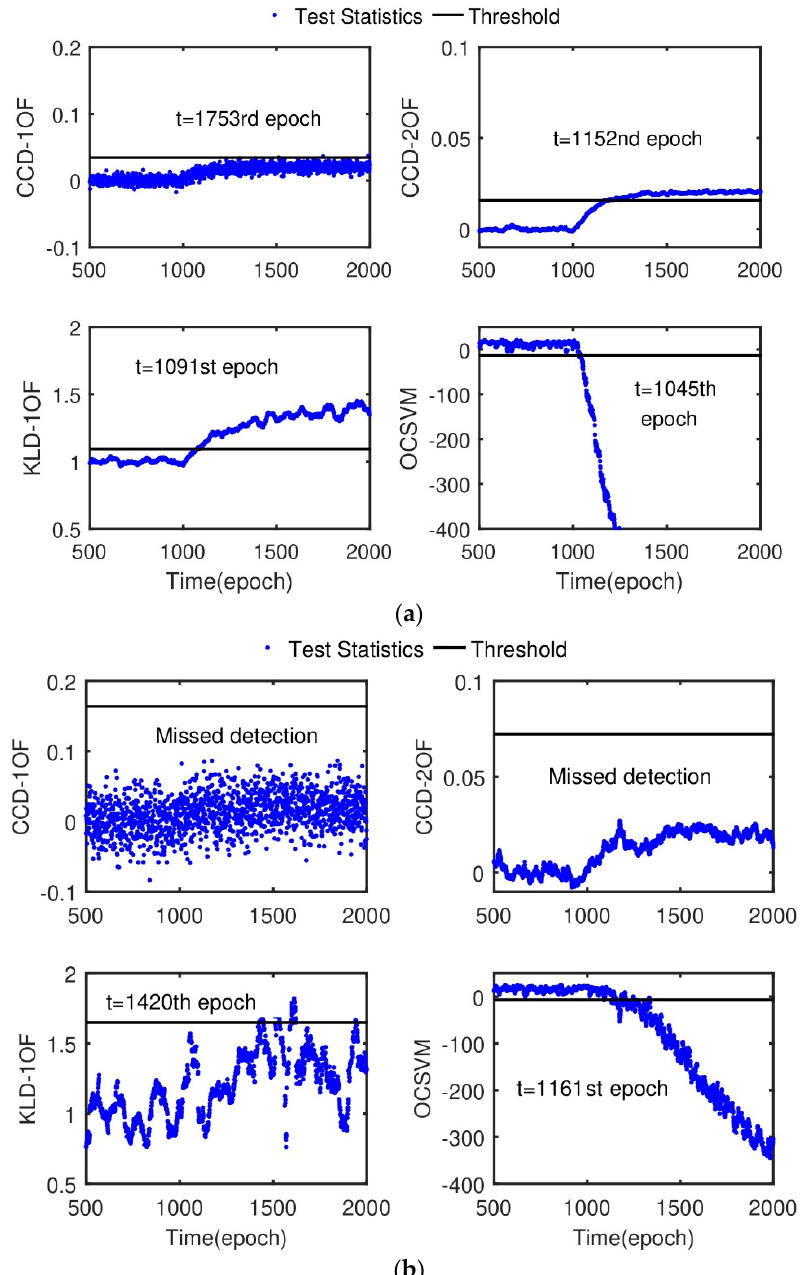
Figure 7. Variation of the test statistics and thresholds of the CCD-1OF, CCD-2OF, KLD-1OF and the proposed OCSVM-based monitors under Gaussian noise, with the noise variance set to 0.5 in ( a ) and 2.5 in ( b ). If the ionospheric anomaly is successfully detected, the detection time is included. Note that the ionospheric anomaly is inserted from the 1000th epoch.